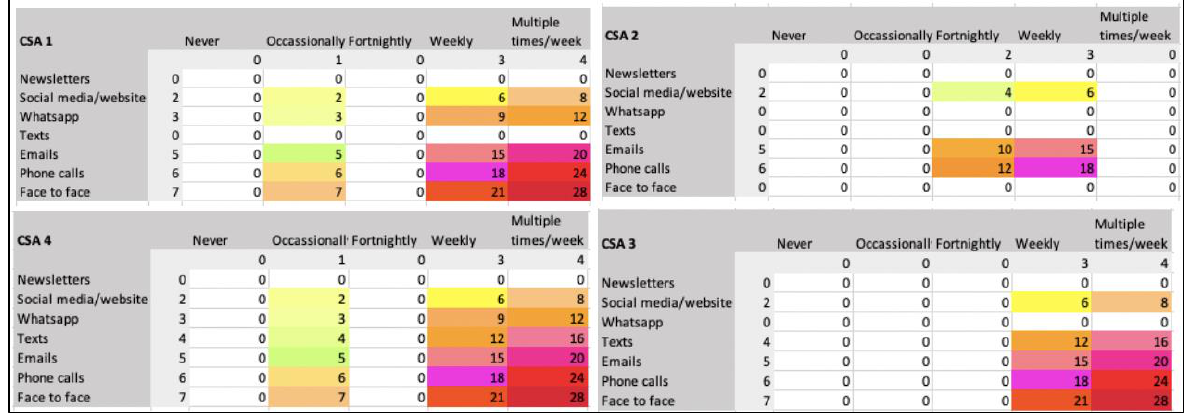
Lighter colors indicate bridging capital and darker colors indicate bonding capital.